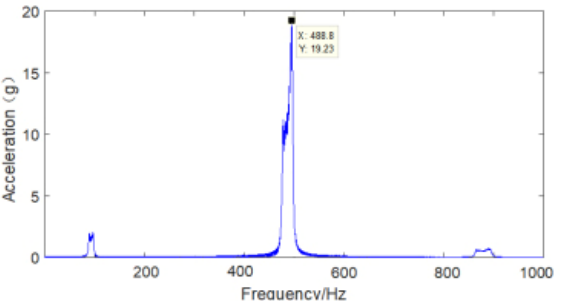
Figure 21. Frequency sweep first-order resonance response of uncoated galvanized iron.